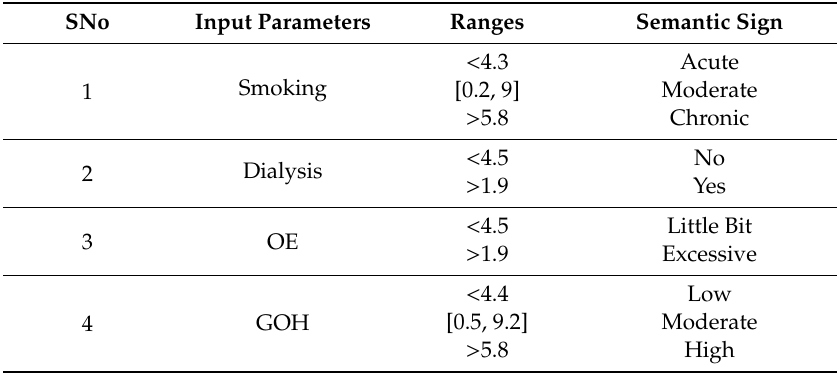
Table 1. Input variables used in layer 1 of the proposed system.